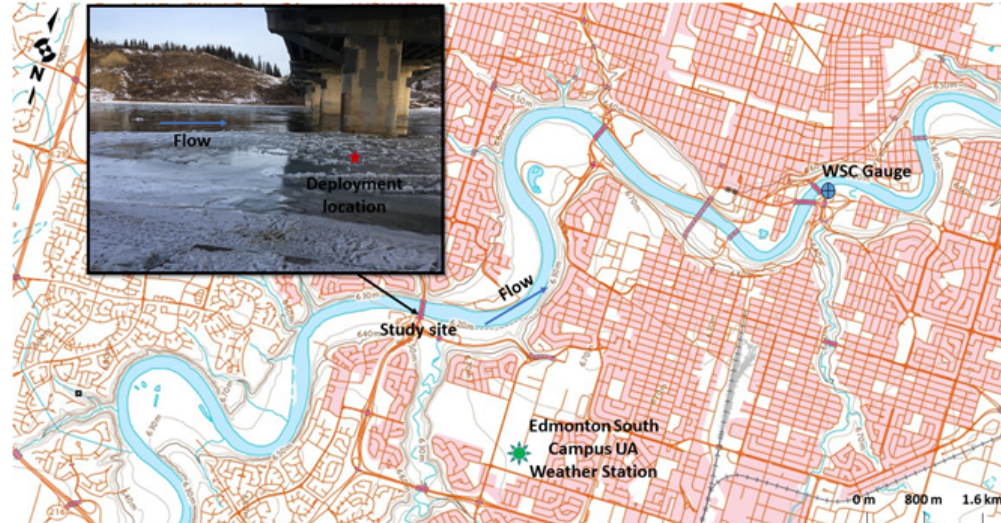
Figure 1. Map showing the study site on the North Saskatchewan River in Edmonton at the Quesnell Bridge (the base map was downloaded from the Atlas of Canada’s Toporama website). The inset is a photo from the right bank looking north showing the deployment site under the bridge.